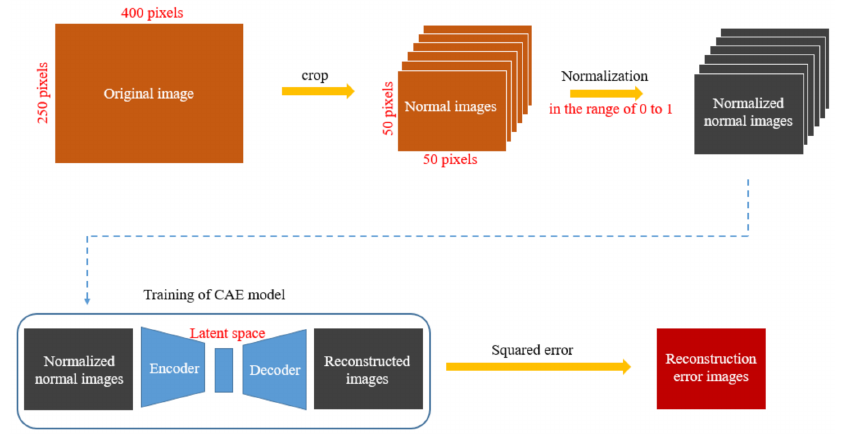
Figure 6. Schematic process of obtaining reconstruction error